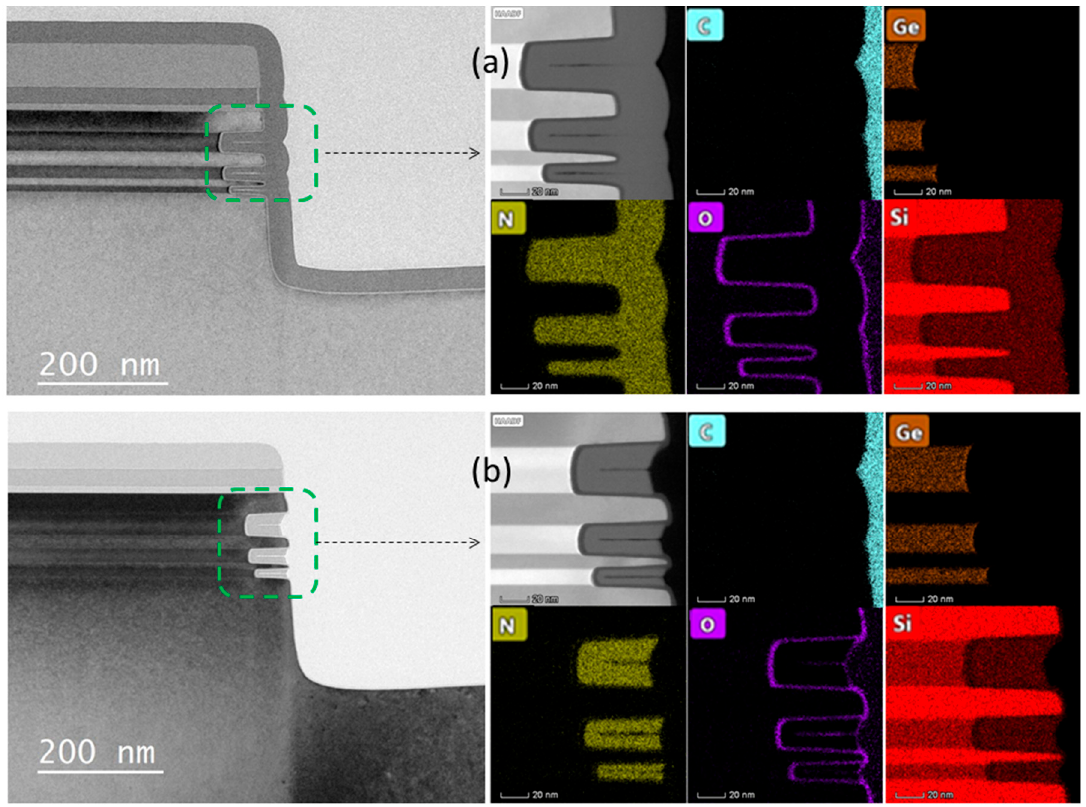
Figure 37. TEM and EDS micrographs: ( a ) LPCVDSilicon nitride inner spacer deposition; ( b ) inner spacer after etching under optimal conditions [195].